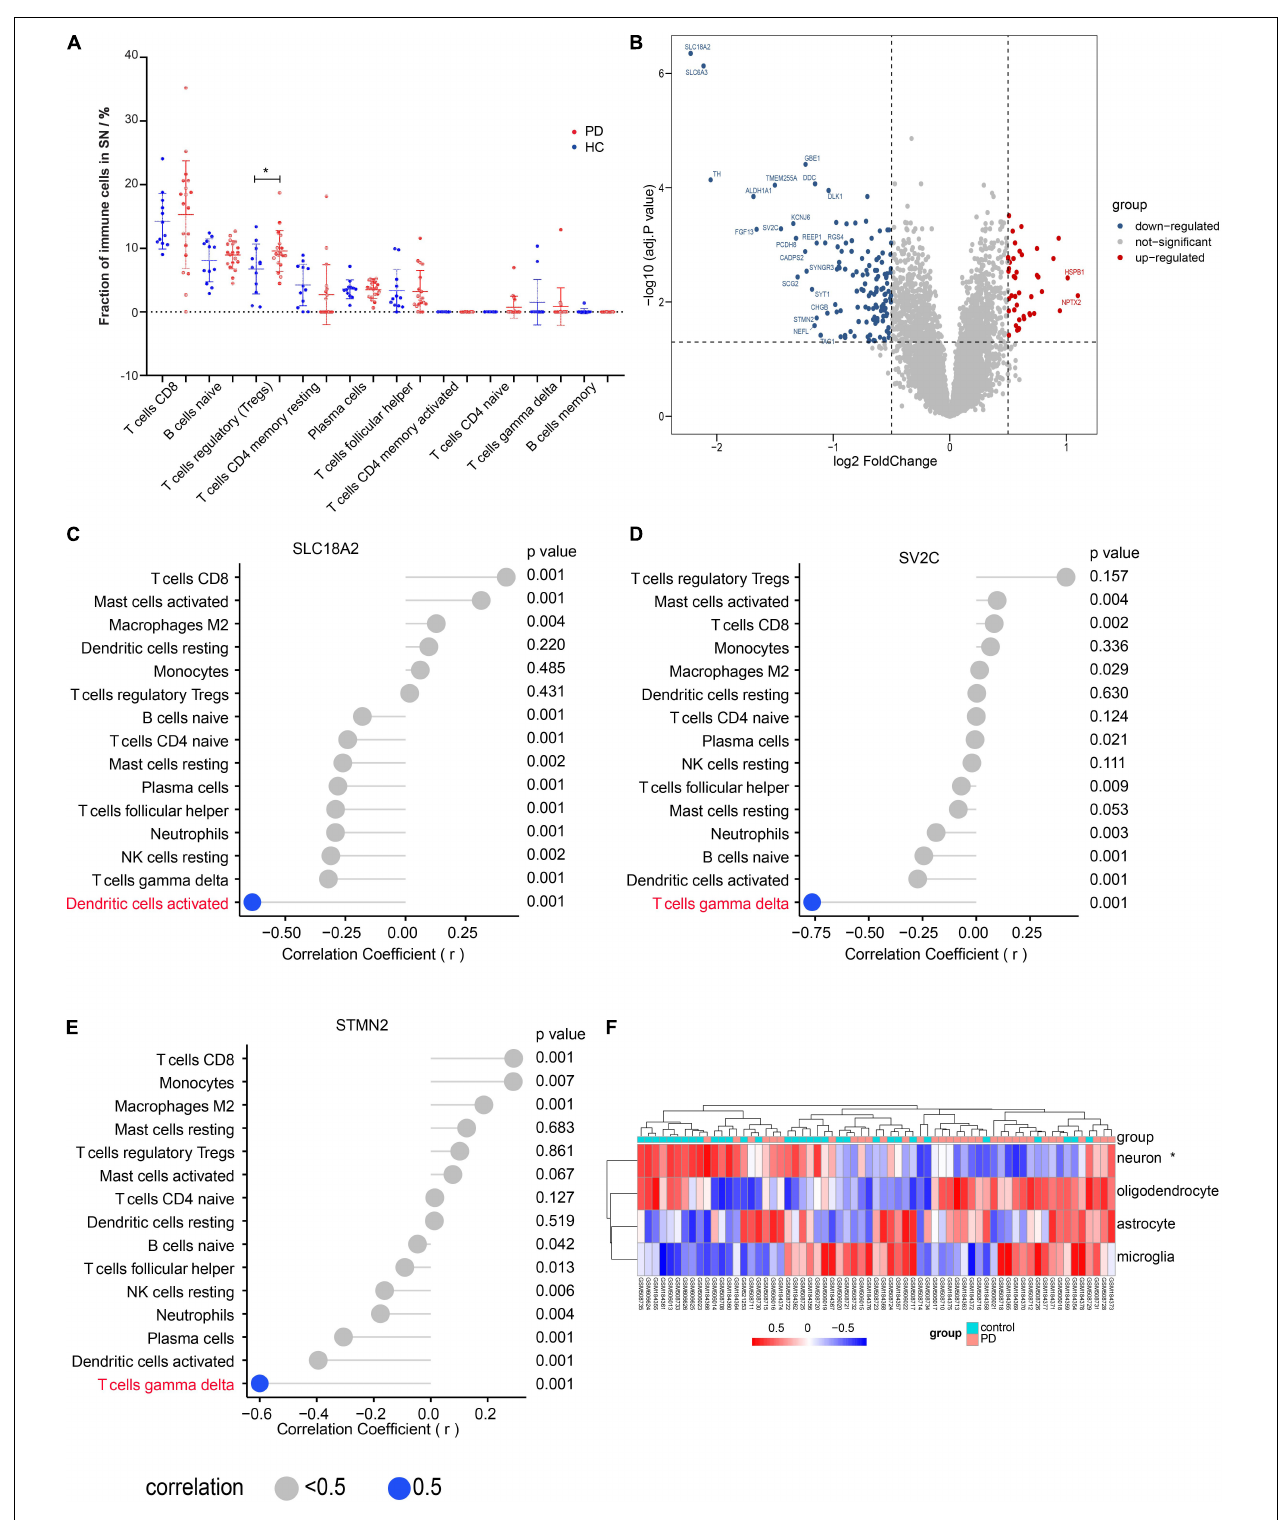
FIGURE 2 | Tregs fraction in substantia nigra (SN) was significantly different between PD and HC. (A) The main immune cell fractions in the SN from PD and HC. The ordinate represents the immune cell fractions, and the abscissa represents the immune cell types. The blue dots represent HC samples, and the red dots represent PD samples. (B) Volcano plot of the differential gene analysis of SN. (C) Correlation between SLC18A2 and immune cells. (D) Correlation between SV2C and immune cells. (E) Correlation between STMN2 and immune cells. (F) The heat map of the enrichment score through the GSVA analysis. * p < 0.05.